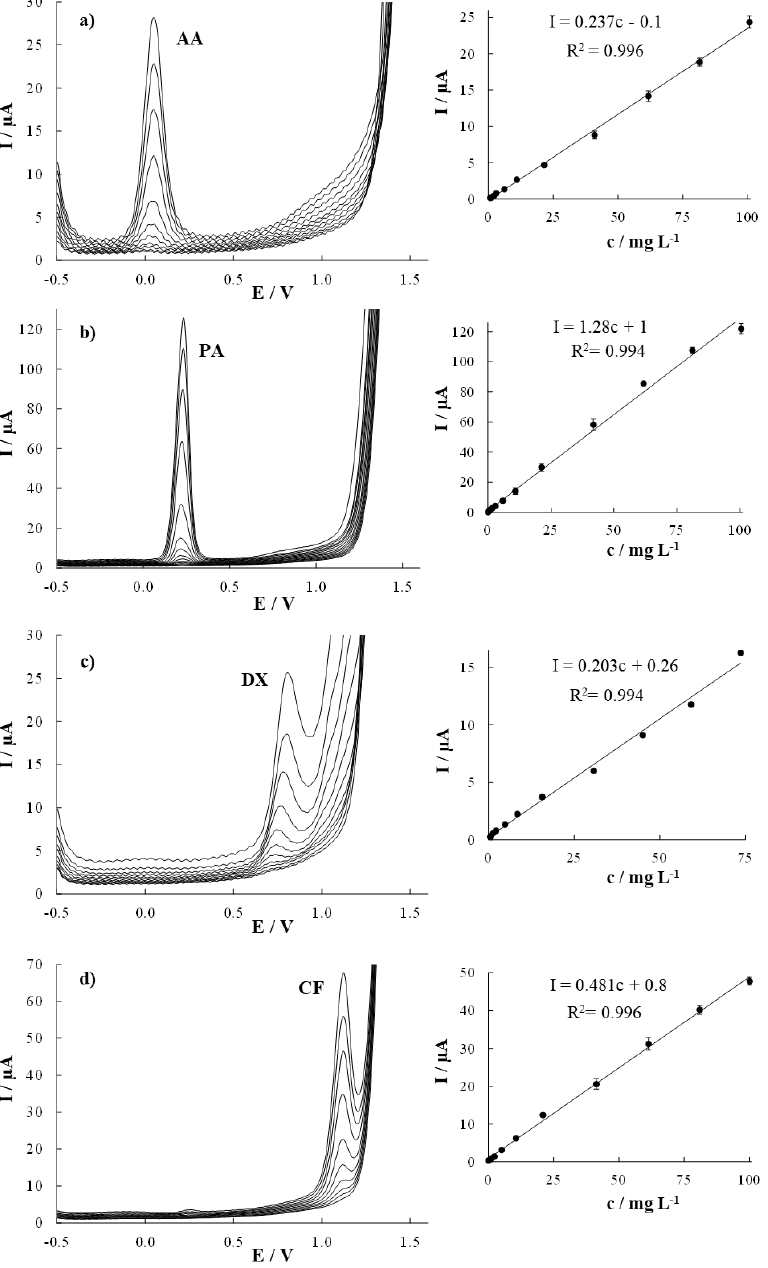
Figure 2. Individual DP voltammograms of ascorbic acid ( a ), paracetamol ( b ), dextromethorphan ( c ) and caffeine ( d ); and their respective calibration plots (insets) in 0.1 mol L −1 acetic/acetate buffer pH 5.00 on SPCE. Error bars in the calibration plots represent the standard deviations from replicate calibration curves carried out with three different electrodes.